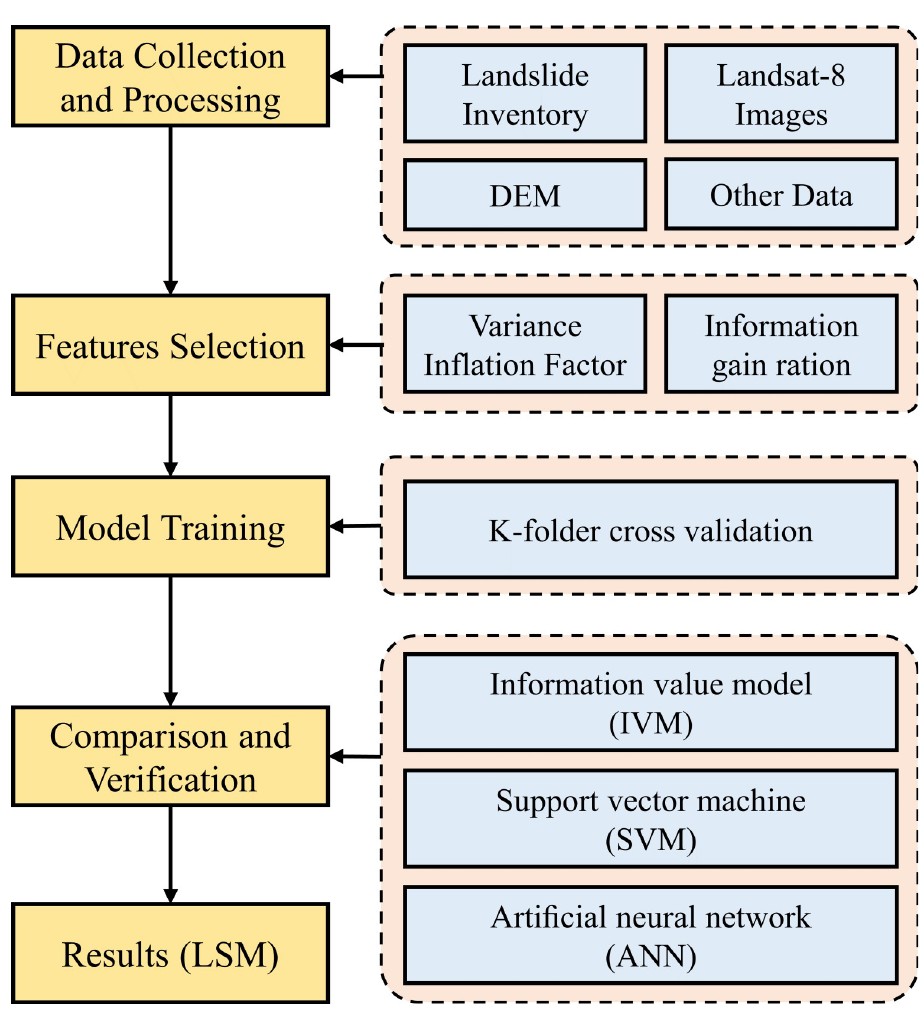
Fig 3. Workflow of the landslide susceptibility analysis.